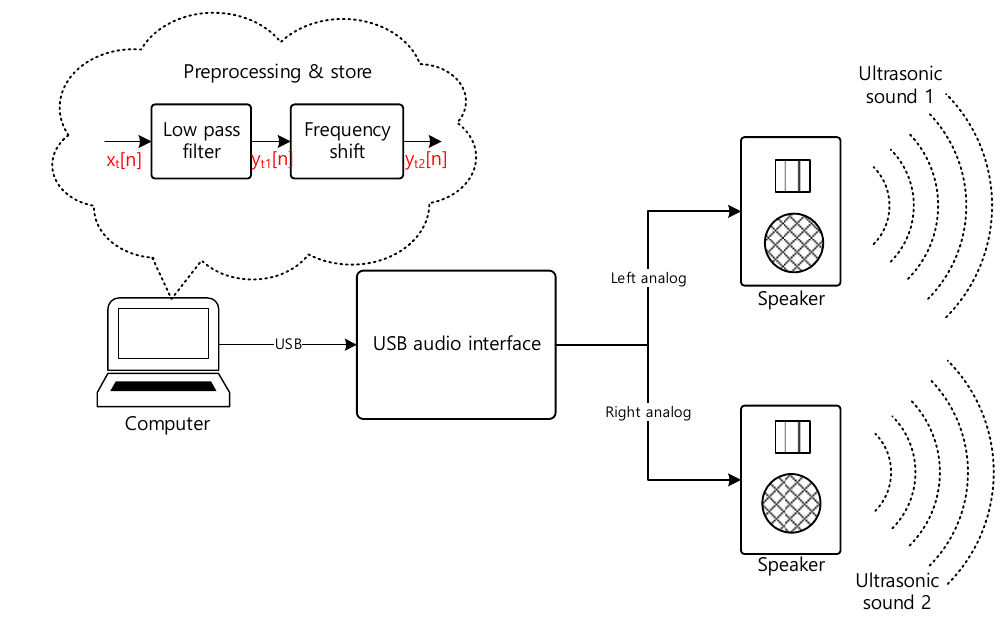
Figure 15. Transmitter device realization.